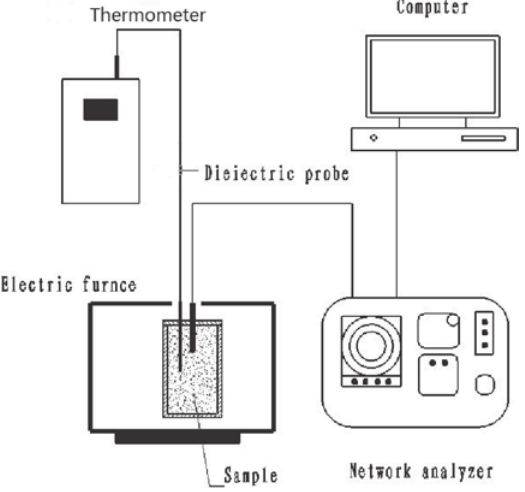
Fig. 1: Schematic diagram of the open ended coaxial line dielectric measurement system